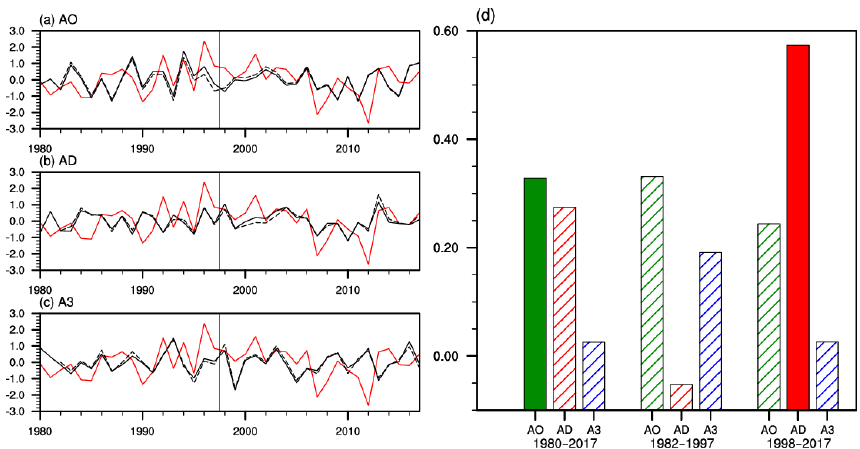
Figure 5. Time series of the three SLP EOFs (solid black) for (a) AO, (b) AD, and (c) A3. Time series of September SIE are also presented in each figure (solid red). In (a, b, c) , the EOF time series from the separate analysis for the period before and after 1998 are also compared (dashed lines in black). (d) is the correlation coefficient between each EOF time series and the September SIE for the entire (1980–2017), early (1982–1997), and recent (1998–2017) period, respectively. A linear trend in each EOF time series was eliminated before calculating correlation. Filled color indicates statistically significant at the 95% confidence level.